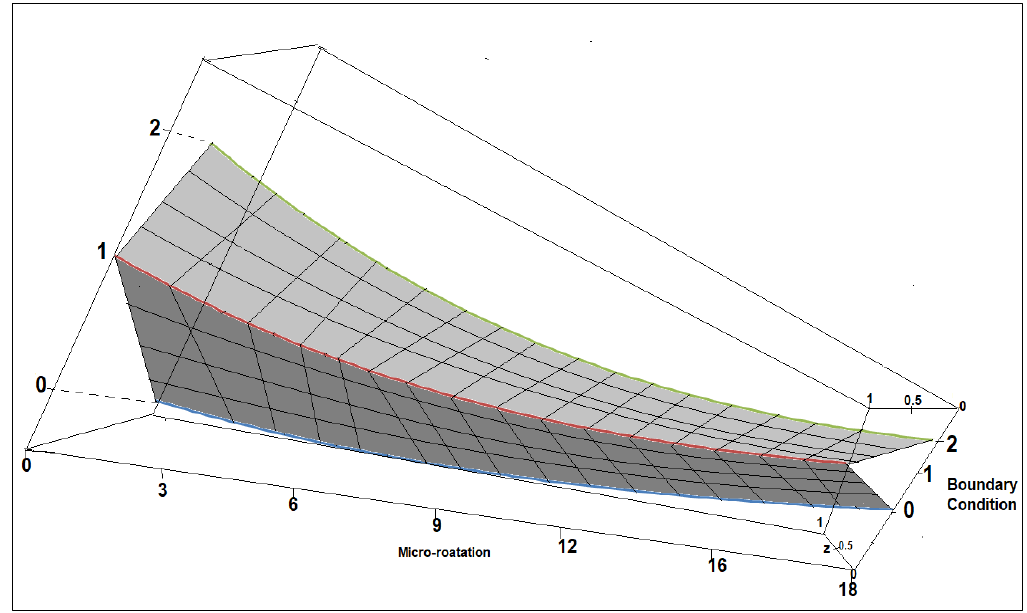
Figure 9. Evolution of membership grade for a micro-rotation profile with the fuzzy